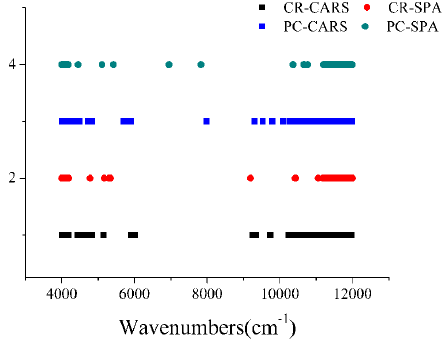
Fig. 6. SPA variable selection on spectra data of CR dataset. Fig. 7. Variables selected based on CARS and SPA method for